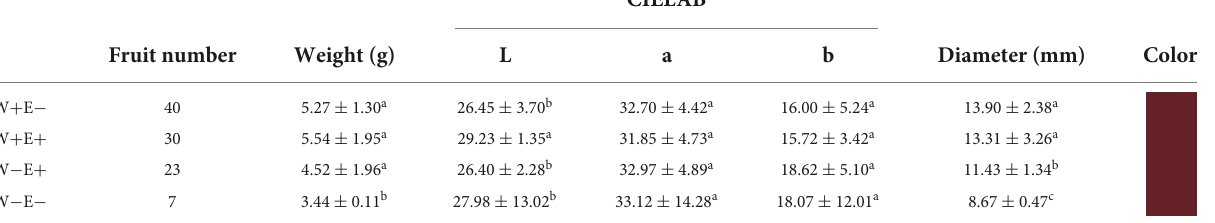
TABLE 2 Productive and quality parameters of strawberry plants.